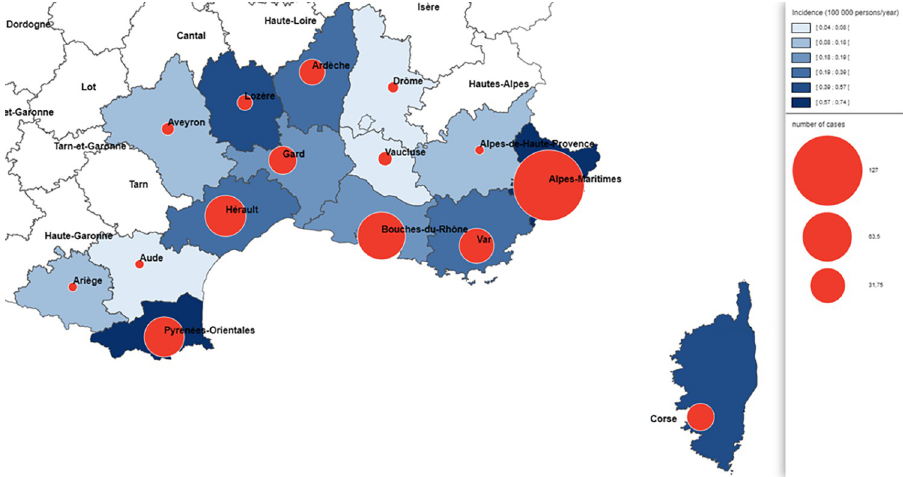
Fig 2. Distribution of the endemic leishmaniasis cases reported in metropolitan France by département (i . e . French administrative regions) from 1998 to 2020 (n = 380; for 137 others cases de´partement of contamination was missing). Maps were designed with the Articque software